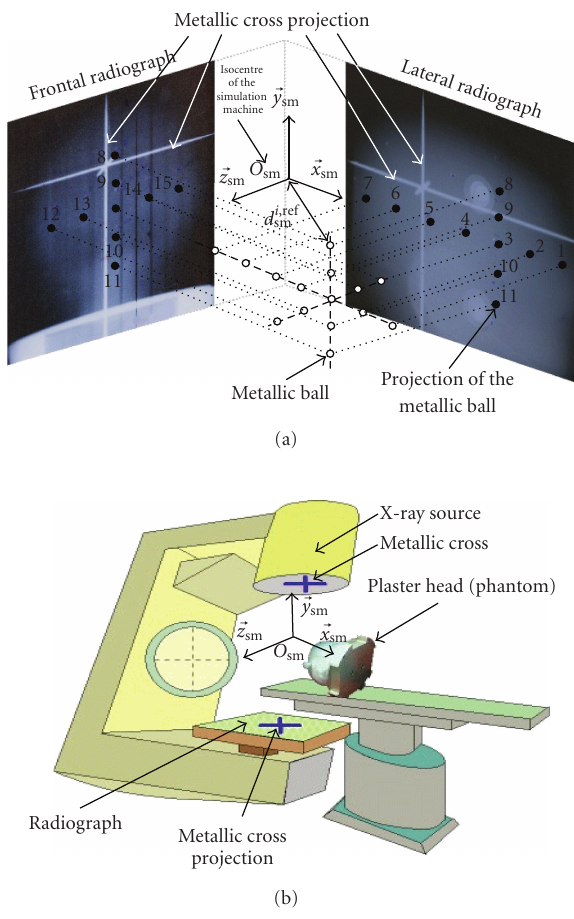
Figure 6: Simulation room. (a) Orthogonal control radiographs. (b) Room geometry.